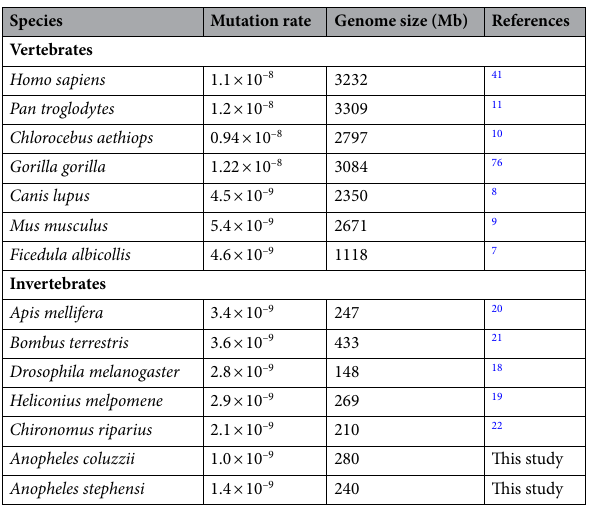
Table 5. Available direct estimates of mutation rate in vertebrates and invertebrates. Mutation rate and genome size of different species of vertebrates and